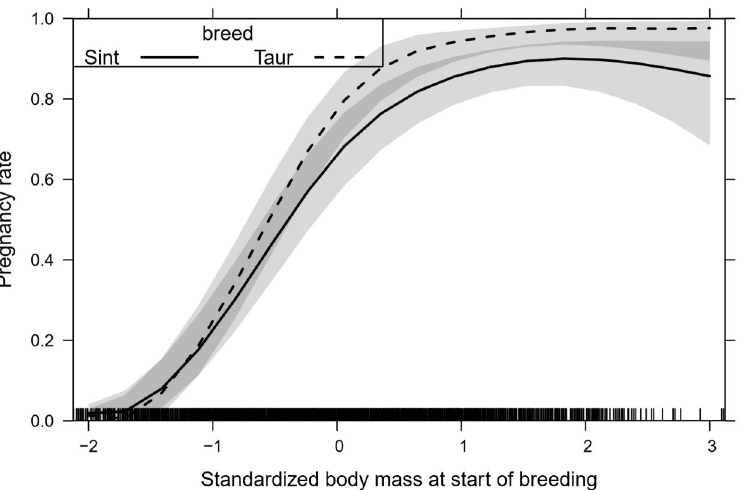
Fig 2. Interaction between body weight at the beginning of the breeding season and Breed to pregnancy rate of heifers and primiparous cows (Sint: Crossbred, Taur: B . taurus females). Shaded strips represent 95% confidence intervals for the expected value. Body mass average and standard deviation were 318 and 69